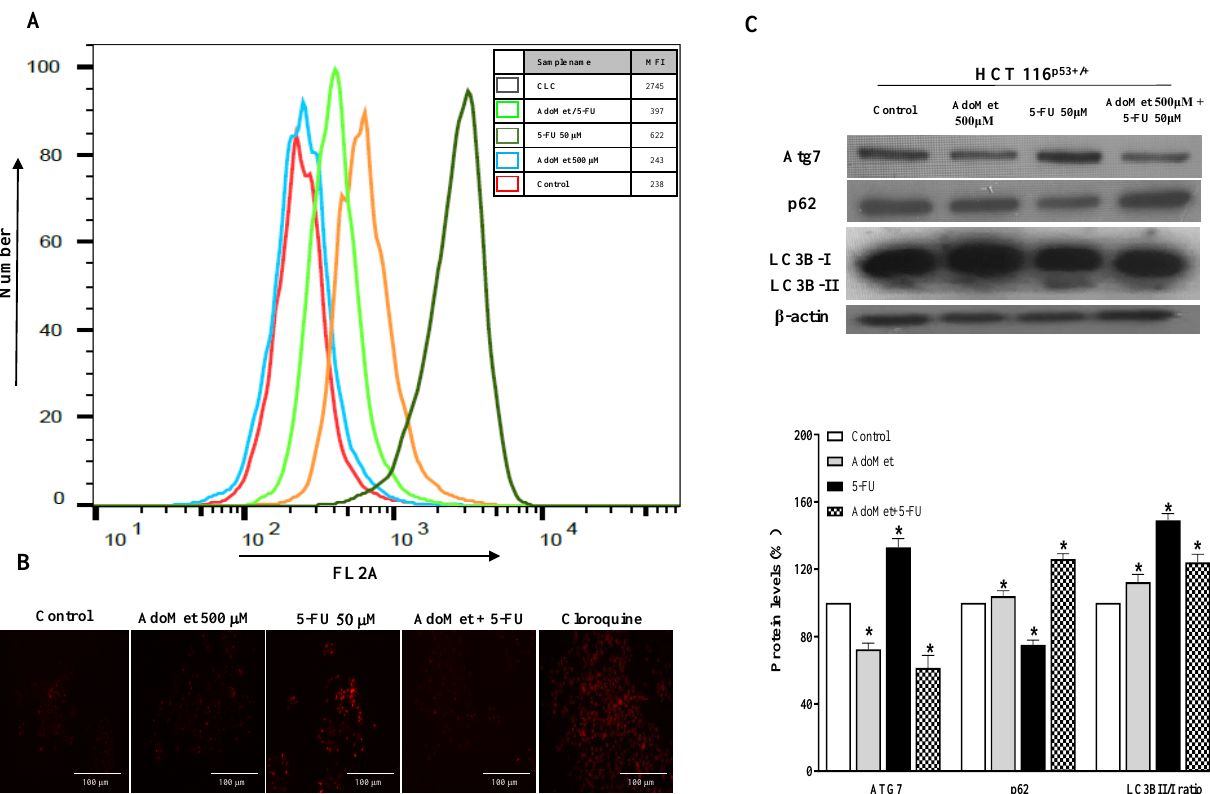
Figure 4. Effects of AdoMet, 5-FU, and their combination on the autophagic process in HCT 116 p53+/+ cells. Cells were treated with 5-FU 50 µ M for 24 h with and without pretreatment with 500 µ M AdoMet for 24 h. Cells were then incubated with LTR and analyzed by flow cytometry ( A ) and fluorescence microscopy ( B ). Chloroquine was used as a positive control. For the quantitative evaluation of autophagy, the FlowJo software was used to calculate median fluorescence intensities (MFI) by the formula (MFI-treated/MFI-control). At least 2 × 10 4 events were acquired in log mode. Analysis was carried out by triplicate determination on at least three separate experiments. ( C ) The protein contents of Atg7, p62, and LC3B-II/I were detected by Western blot analysis using the total cell lysates. The house-keeping protein β -actin was used as loading control. The graph shows the relative densitometric analyses, expressed as percentage of untreated control (100%). Error bars represent the standard deviation, * p < 0.05 versus untreated cells. The images are representative of three immunoblotting analyses obtained from three independent experiments. Full-length blots are shown in Figure